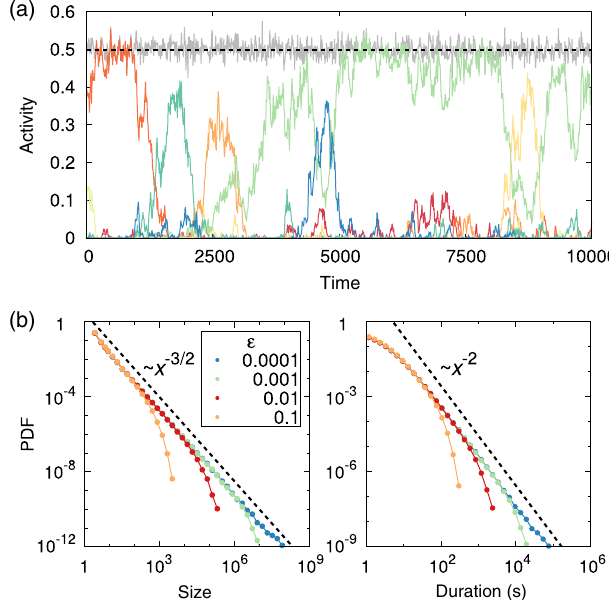
FIG. 3. Causal avalanches in a minimal model for propagation activity, defined as cascades of events initiated from the sponta- neous activation of one unit, without overlap between avalanches (i.e., a given node cannot be simultaneously part of more than one avalanche). (a) The activity of each avalanche is defined as the density of active elements in the system belonging to that avalanche, identified with different colors in the plot. The global activity density is represented with the gray colored line. Param- eters of the model are taken deep inside the active phase, λ ¼ 2 , μ ¼ 1 , for a system size N ¼ 10 4 and small spontaneous activation rate ϵ ¼ 10 − 3 . Whereas the global activity exhibits slight fluctua- tions around its steady-state value ρ (cid:2) ≃ 1 − μ = λ (represented by the dashed line), individual avalanches can exhibit wild variability. (b) Probability distribution functions (PDF) for avalanche sizes and durations for different values of ϵ [other parameters as in (a), i.e., deep inside the active phase]. Avalanche statistics exhibit robust power-law scaling — limited by system size — with the same ex- ponents of the neutral theory for avalanche propagation (marked with dashed lines for